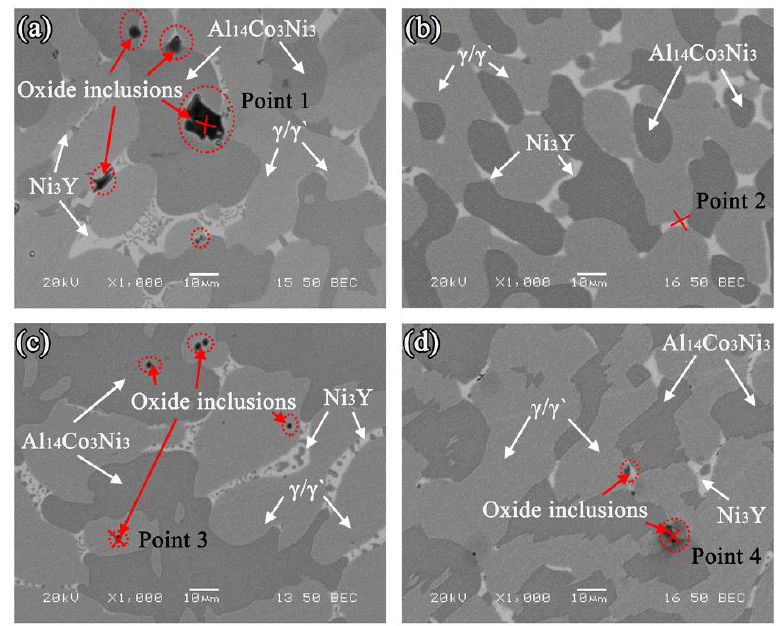
Figure 8. The morphologies of the alloy matrices: ( a ) MgO; ( b ) Y 2 O 3 ; ( c ) Al 2 O 3 ; and ( d ) ZrO 2 .